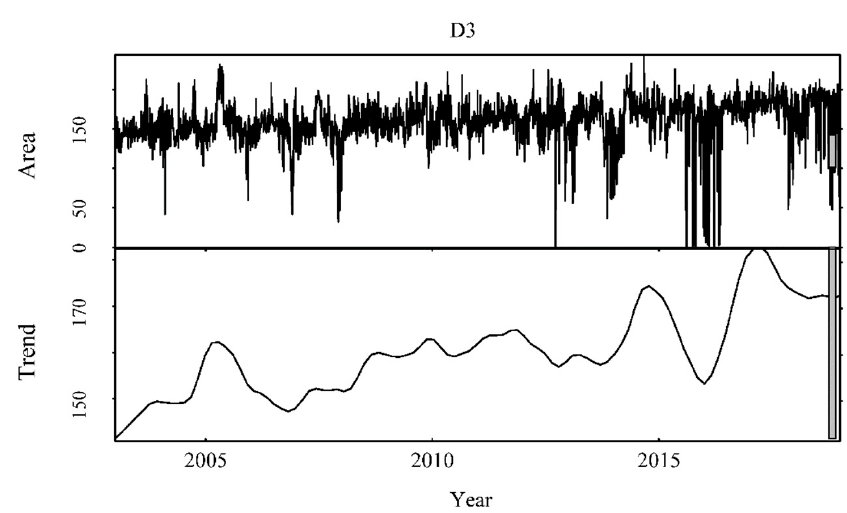
Figure 13. Time series decomposition of the daily urban heat island area during the central heating season.